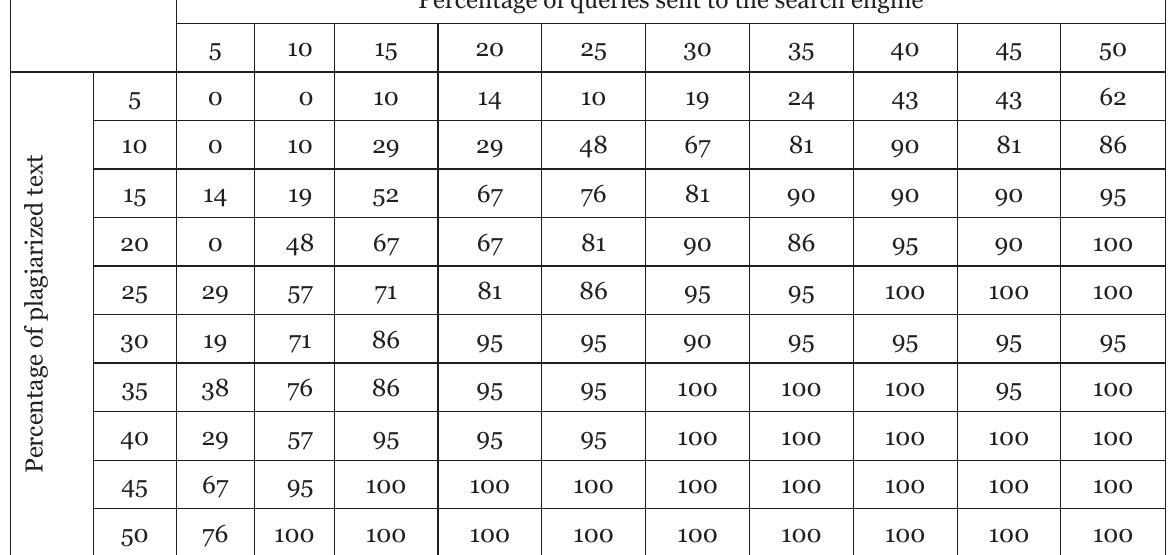
Note. 210 generated assignments taken from 21 source documents.